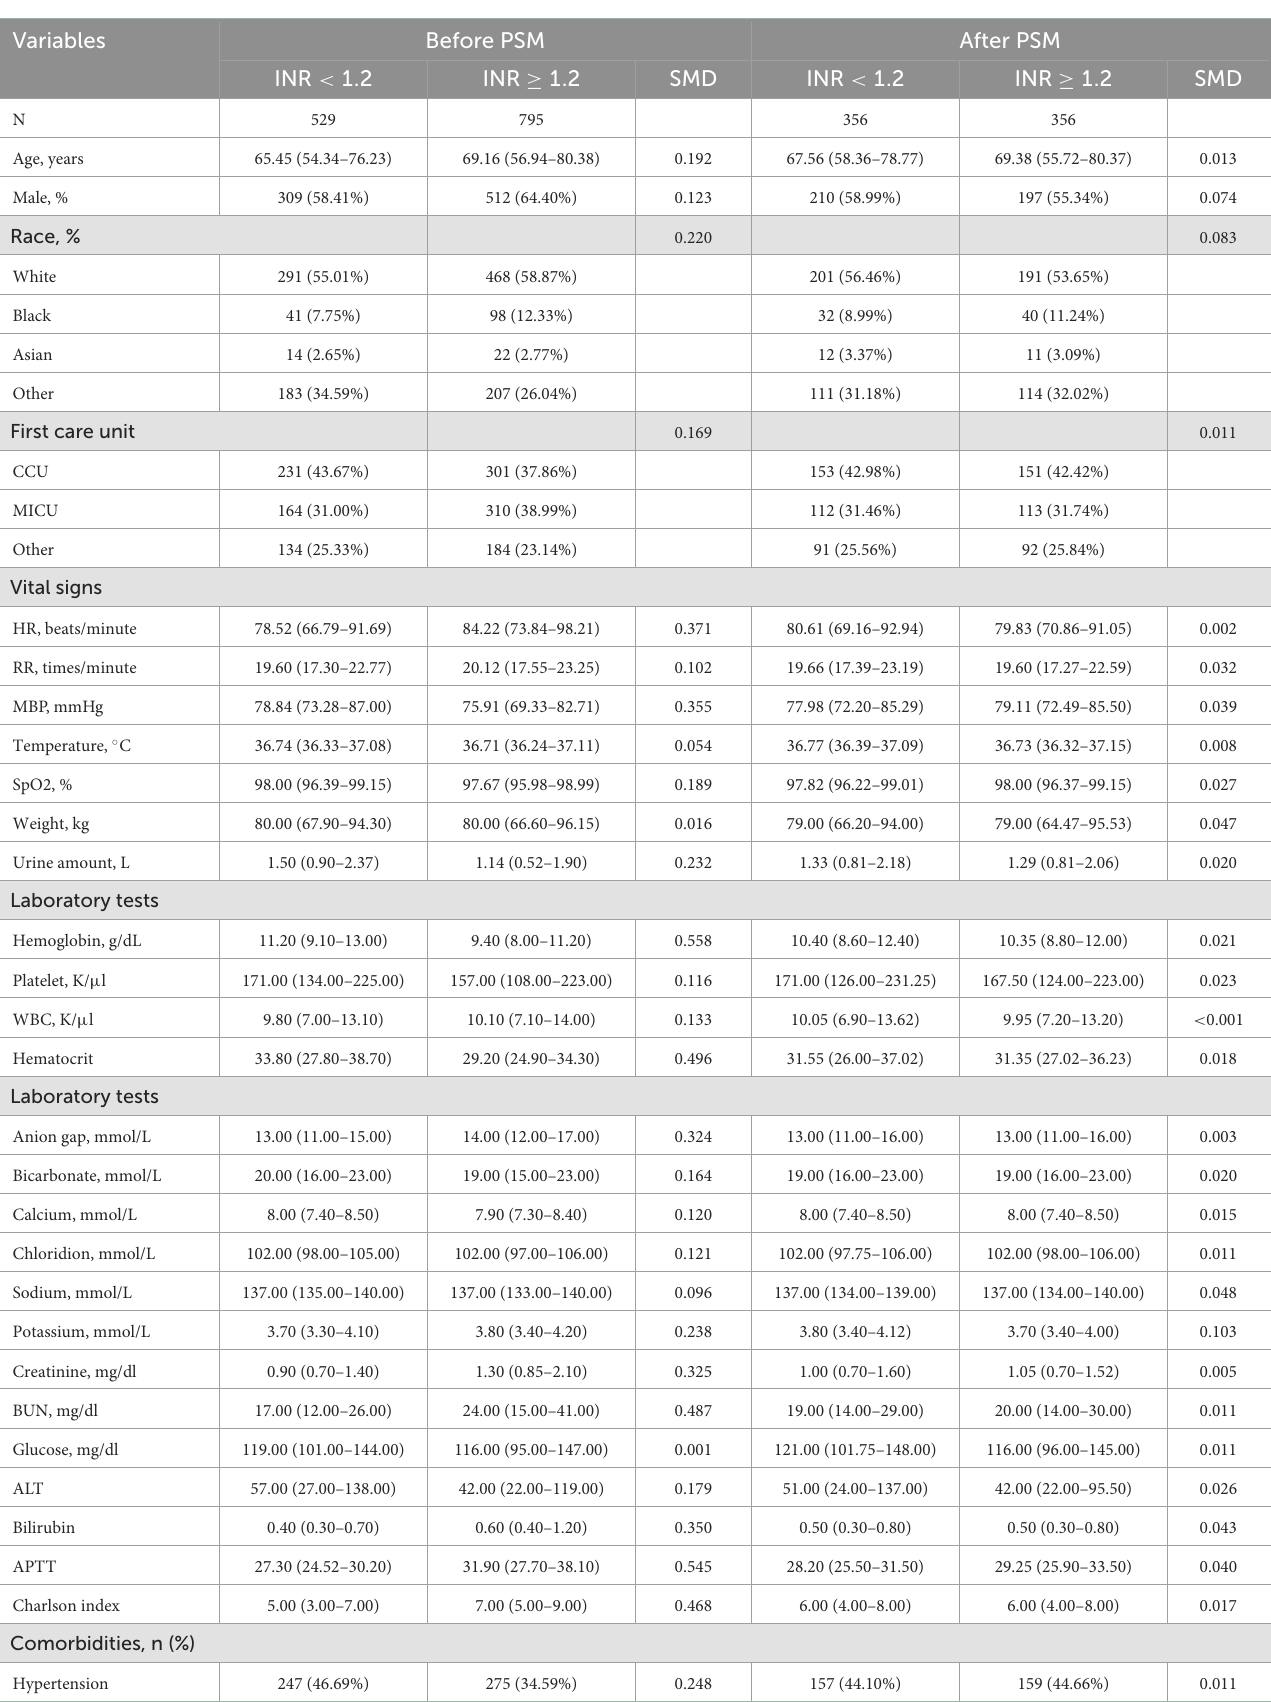
TABLE 2 The baseline characteristics of post-CA patients grouped by INR before and after